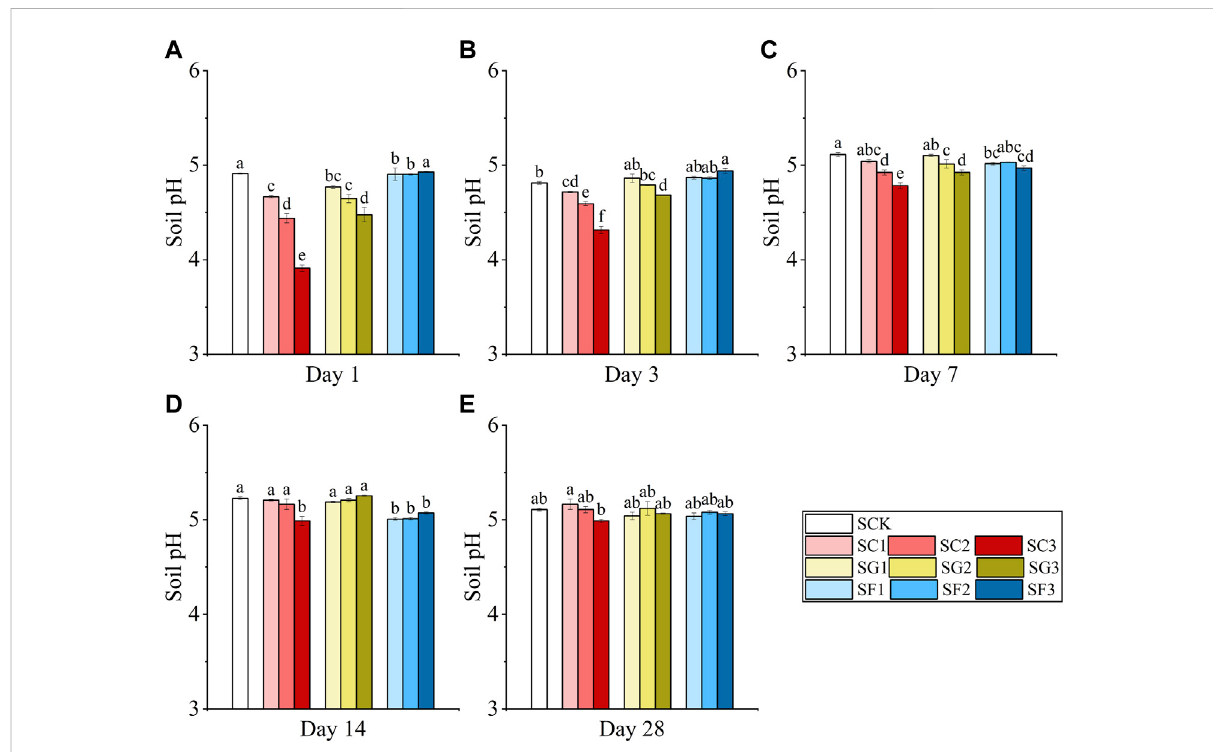
FIGURE 1 Changes in soil pH under different fractions and dosages of single citric acid (SC1, SC2, SC3), Gly (SG1, SG2, SG3), and fructose (SF1, SF2, SF3) application on days 1 (A) , 3 (B) , 7 (C) , 14 (D) , and 28 (E) (Different letters in each sampling timepoint show signi fi cant differences, p <